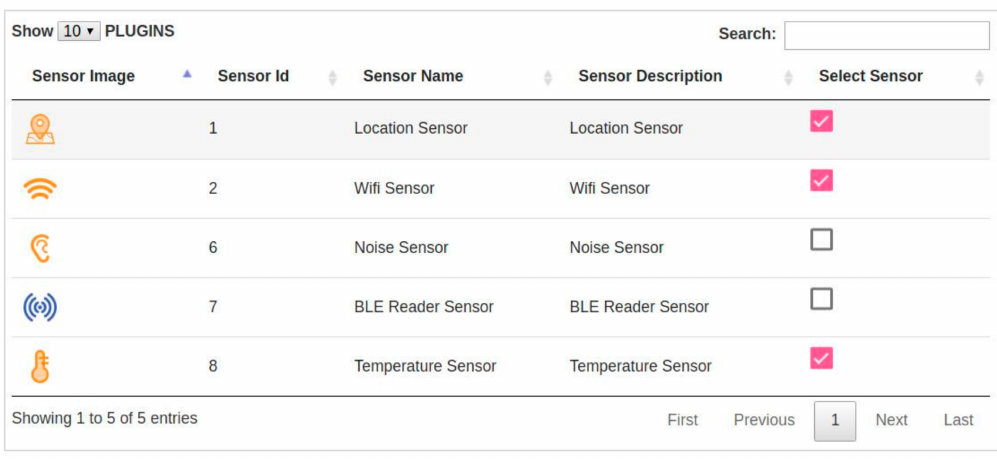
Figure 4. Screenshot of the Experimenter Portal to select experimentation